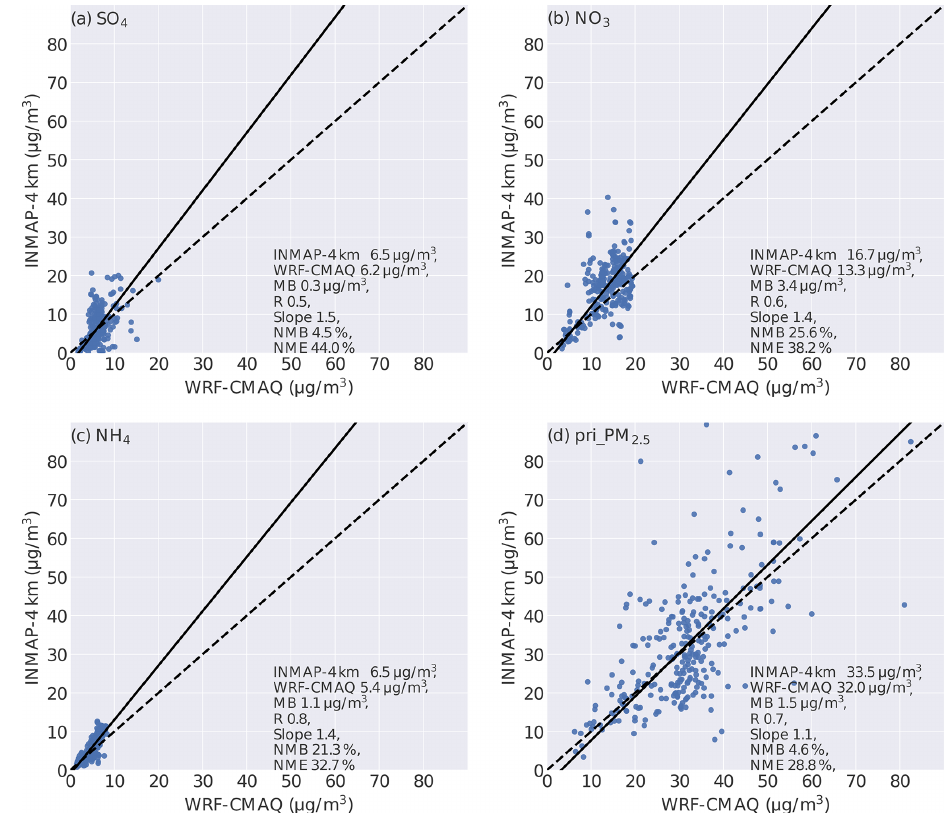
Figure 11. Scatterplot comparing the PM 2 . 5 composition concentration modeled in the BTH region at a 4km spatial resolution by the InMAP-China and WRF-CMAQ models. Panels (a) , (b) , (c) and (d) display the sulfate, nitrate, ammonium and primary PM 2 . 5 , respectively. The statistical metrics are given in the lower right-hand corner of each